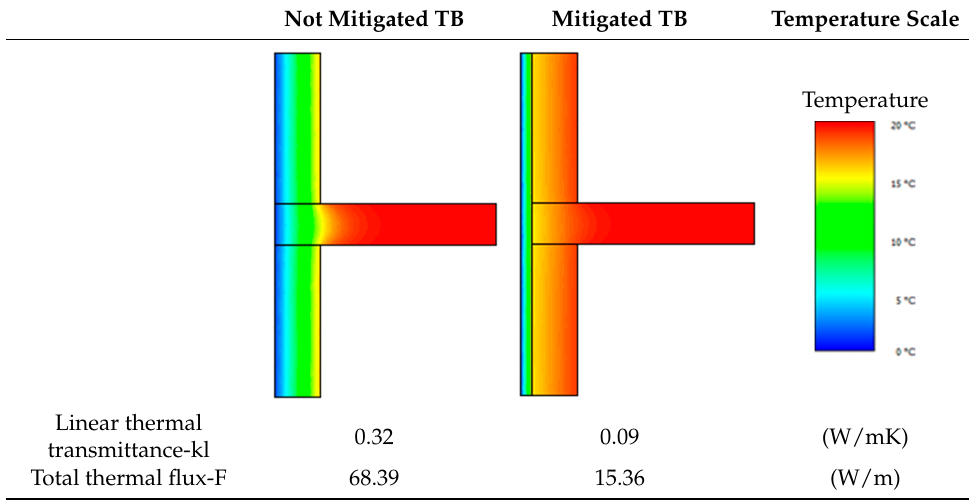
Table 12. IF Thermal bridges.